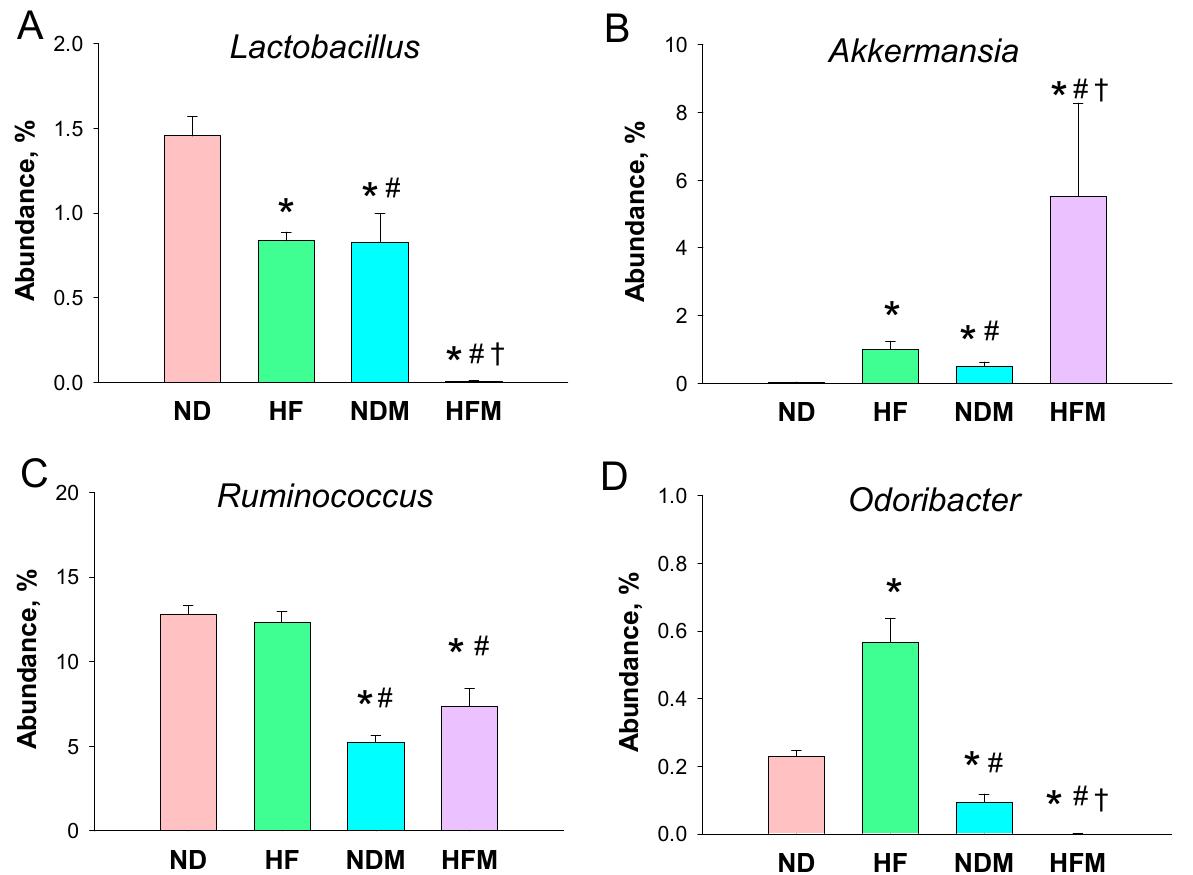
Figure 4. Effect of high-fructose diet (HF) and minocycline administration (M) on the gut microbiome in male offspring. Relative abundance of the genera ( A ) Lactobacillus, ( B ) Akkermansia, ( C ) Ruminococcus , and ( D ) Odoribacter . Data are shown as means ± SEM; N = 5–8/group. * p < 0.05 vs. ND; # p < 0.05 vs. HF; † p < 0.05 vs. NDM.